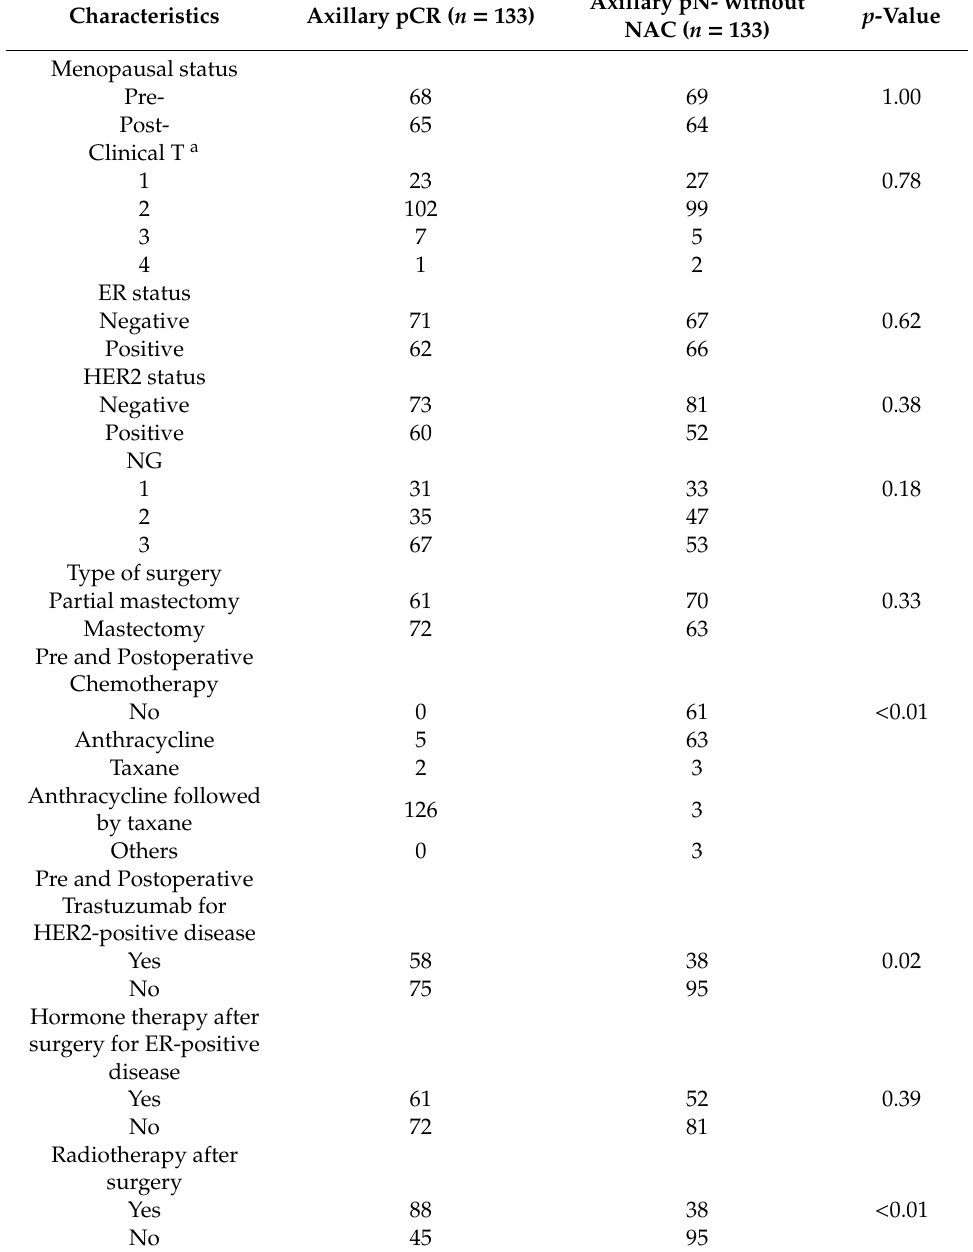
Table 4. Baseline characteristics at diagnosis of patients with axillary pCR and axillary pN- without NAC, using propensity score